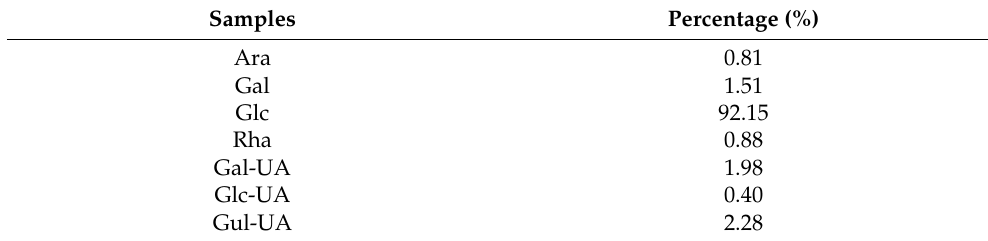
Table 5. Monosaccharide compositions of cMORP.